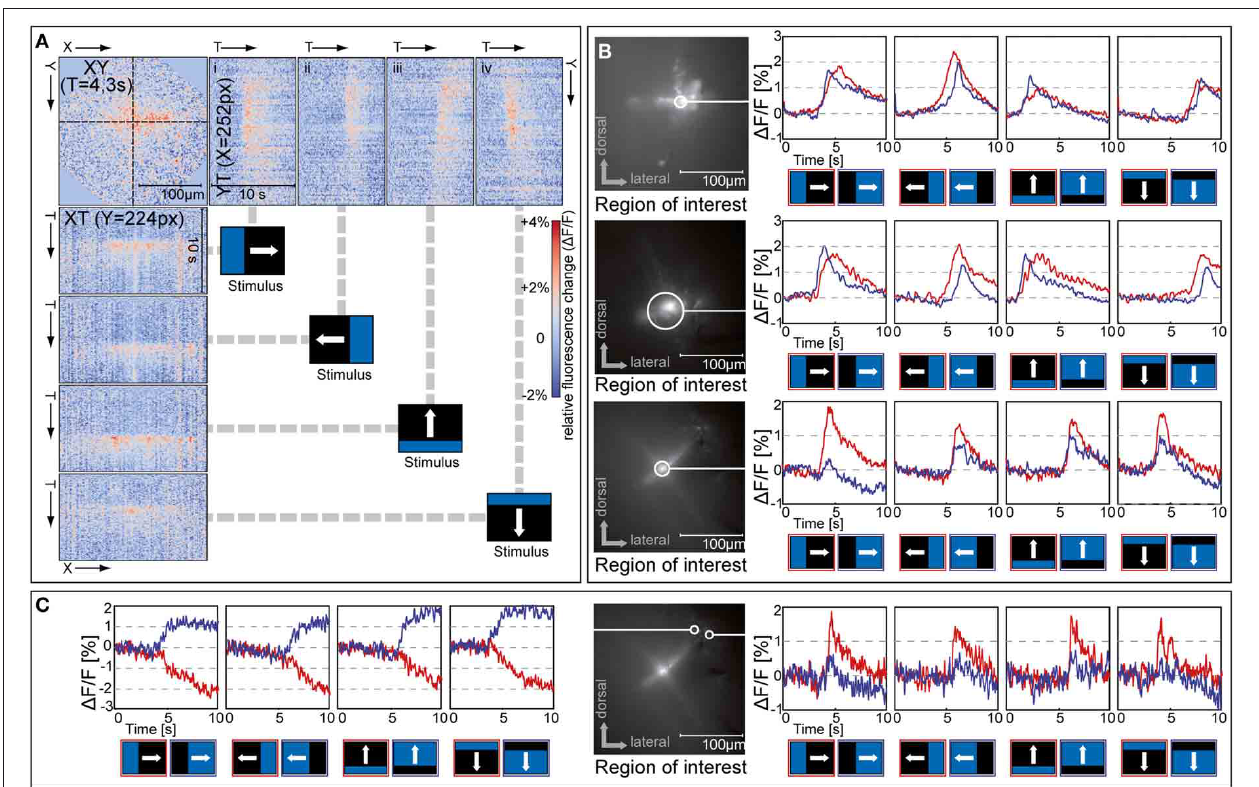
in response to a bright moving bar stimulus. Similar results were obtained in five further stainings. (B,C) Relative fluorescence changes ( (cid:3) F / F ) in the region of interest indicated in response to a bright edge (red) and dark edge (blue) drifting in four directions. Regions of interest in C are centered on two somas near the distal rim of the medulla. Stimuli were presented on a 60Hz TFT